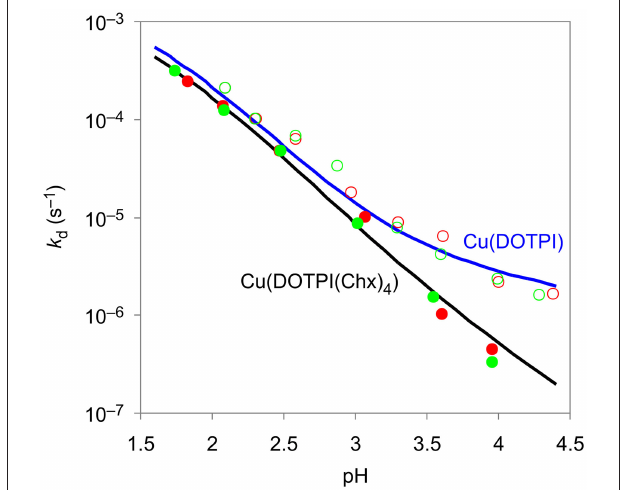
FIGURE 2 | Pseudo-first-order rate constants at 25 ◦ C in 0.15M NaCl for the reaction of Cu II complexes of DOTPI (empty symbols) and DOTPI(Chx) 4 (filled symbols) with a 20- (red) and 40-fold (green) excess of EDTA at different pH values. Respective k d functions were calculated from kinetic and equilibrium